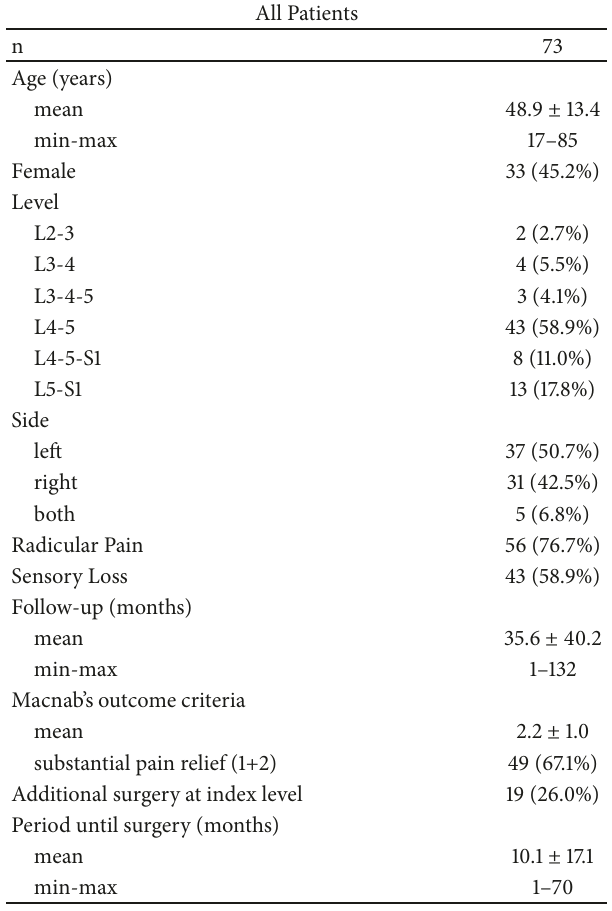
Table 1: Patient